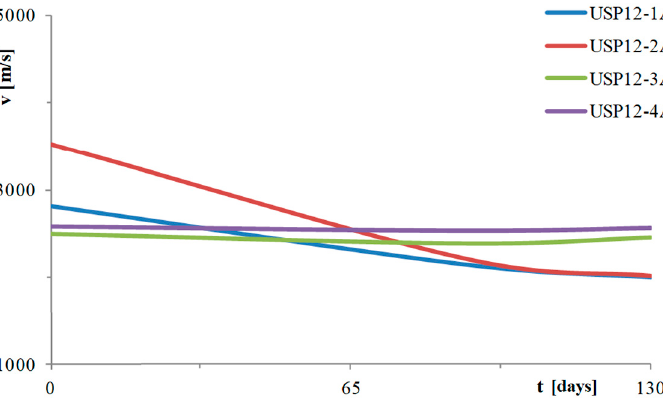
Figure 8. Ultrasound wave rate-time of ageing—circular pier.